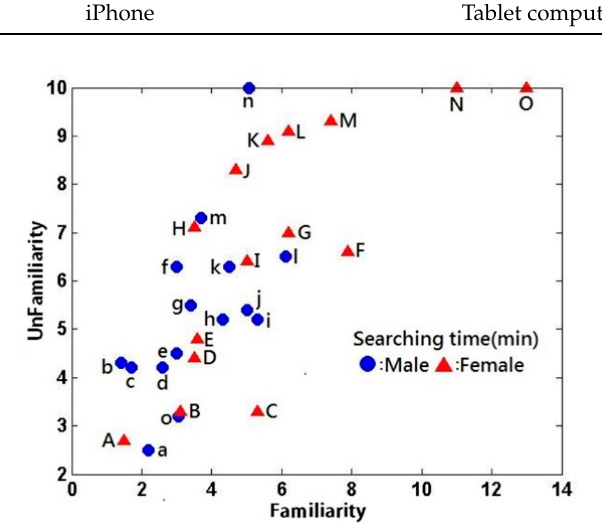
Figure 3. Product search time in minutes.